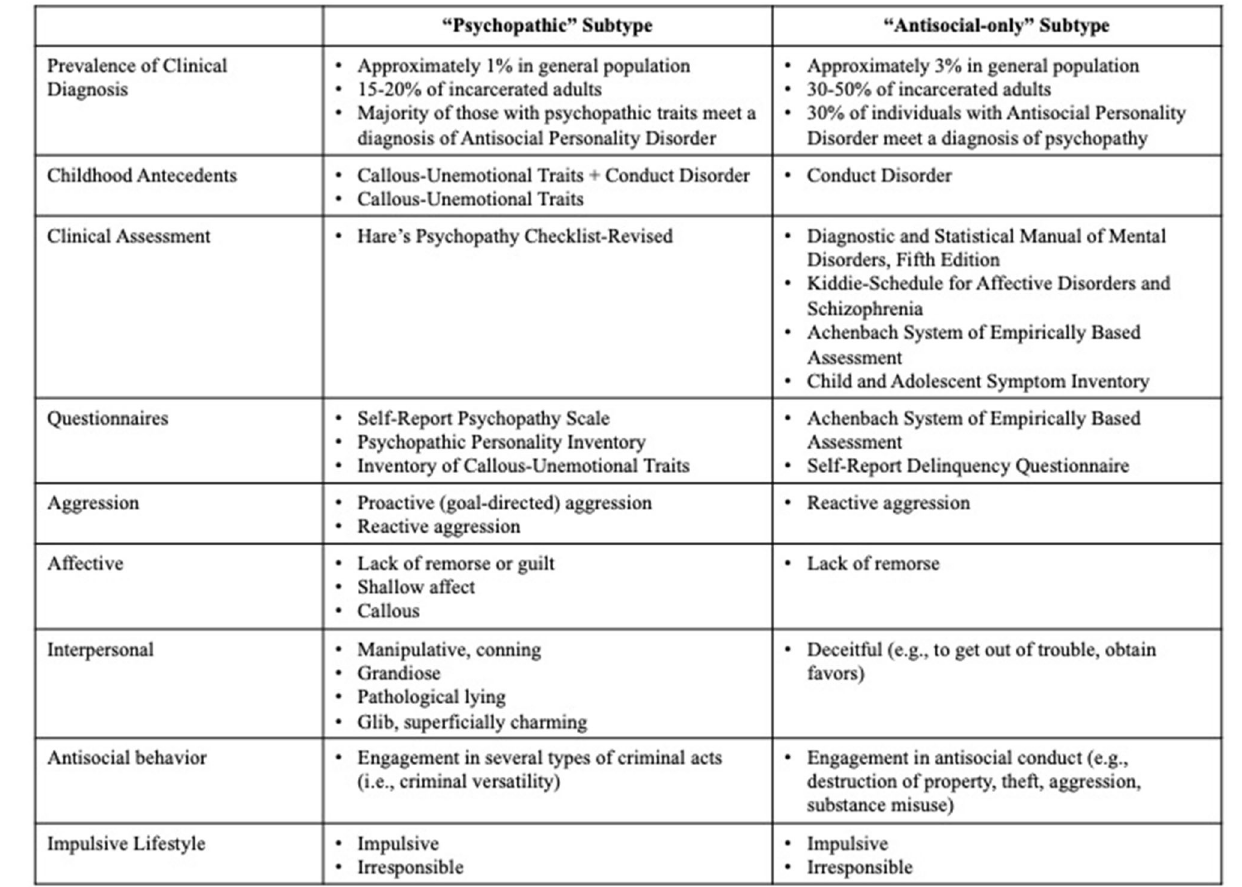
of dots in a room, is influenced by the perspective of a task irrelevant agent, such as determining the number of dots from the perspective of an